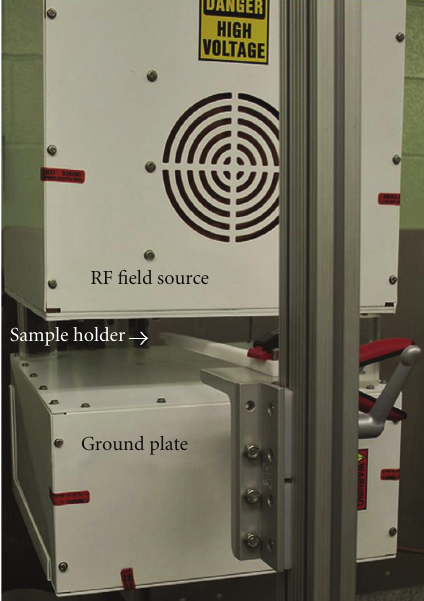
Figure 2: Kanzius RF generator: RF field source transmission antenna (Tx head) and ground plate (Reciprocal Rx head) are separated by 10cm air-gap. Samples are placed 2.5cm from the Tx head on the Teflon holder.